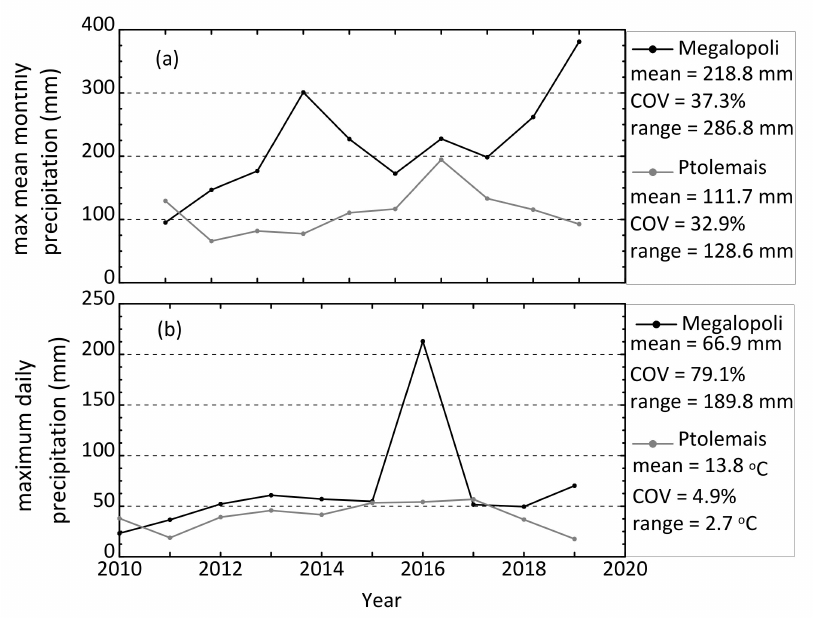
Figure 4. Measurements for the last ten years of ( a ) maximum mean monthly and ( b ) maximum daily